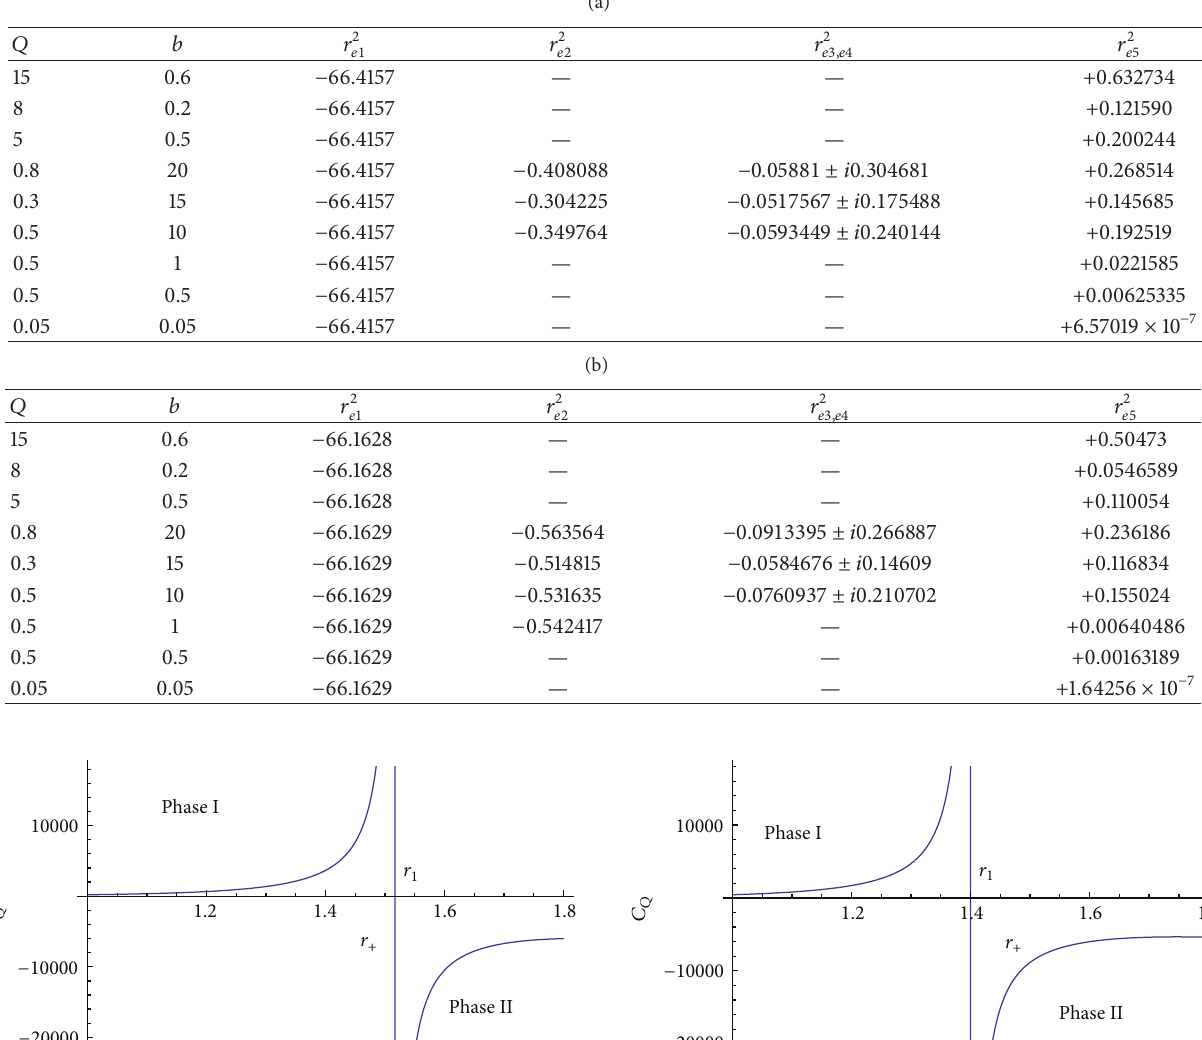
Table 2: (a) Roots of (44) for 𝛼 󸀠 = 0.5 and 𝑙 = 10 . (b) Roots of (44) for 𝛼 󸀠 = 1.0 and 𝑙 = 10 .